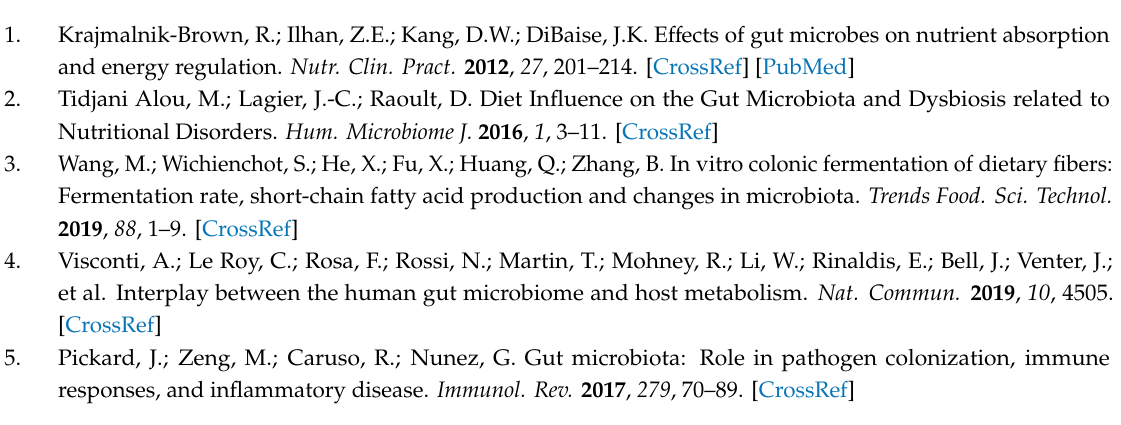
Supplementary Materials: The following are available online, Figure S1a,b: Prebiotic Indexes (PIs) of the tested mushrooms and controls after 24 h fermentation for the first 4 runs of the in vitro fermentation experiment, Table S1: Prebiotic Indexes (PIs) per subject for each one of the treatments included in this study, Figure S2a–d: Linear regression analysis of log 10 -transformed mean Prebiotic Indexes (PIs) of the tested mushrooms with average total glucan content (a,c) and average β -glucan content (b,d) for all available data (a,b) and for the first 4 runs (c,d) of the in vitro fermentation